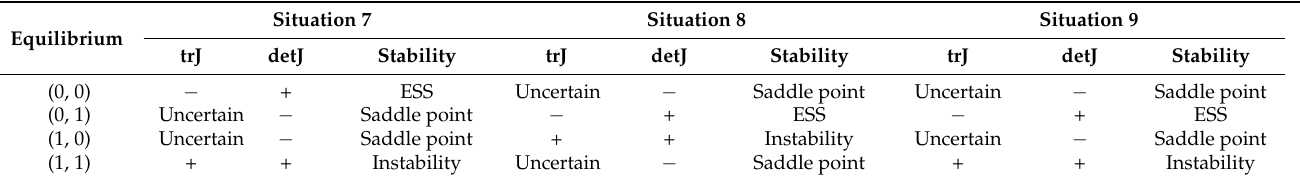
Table 5. Local stability of the equilibrium point (Situations 7, 8 and